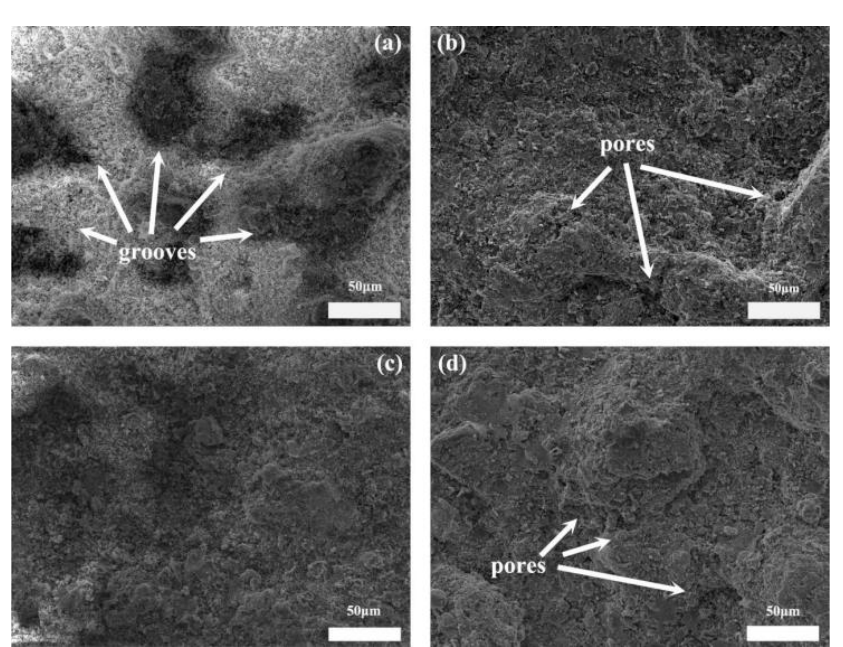
Figure 3. The SEM surface images of the ZrSi 2 -SiC coatings with different ZrSi 2 contents. ( a ) 10 wt.% ZrSi 2 -90 wt.% SiC; ( b ) 20 wt.% ZrSi 2 -80 wt.% SiC; ( c ) 30 wt.% ZrSi 2 -70 wt.% SiC; ( d ) 40 wt.% ZrSi 2 -60 wt.% SiC.